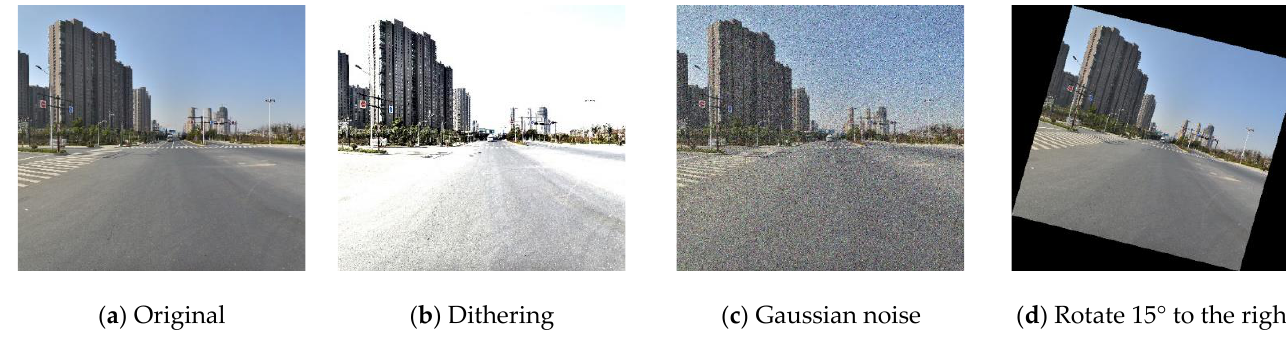
Figure 10. Strategies for dataset balancing and expansion.